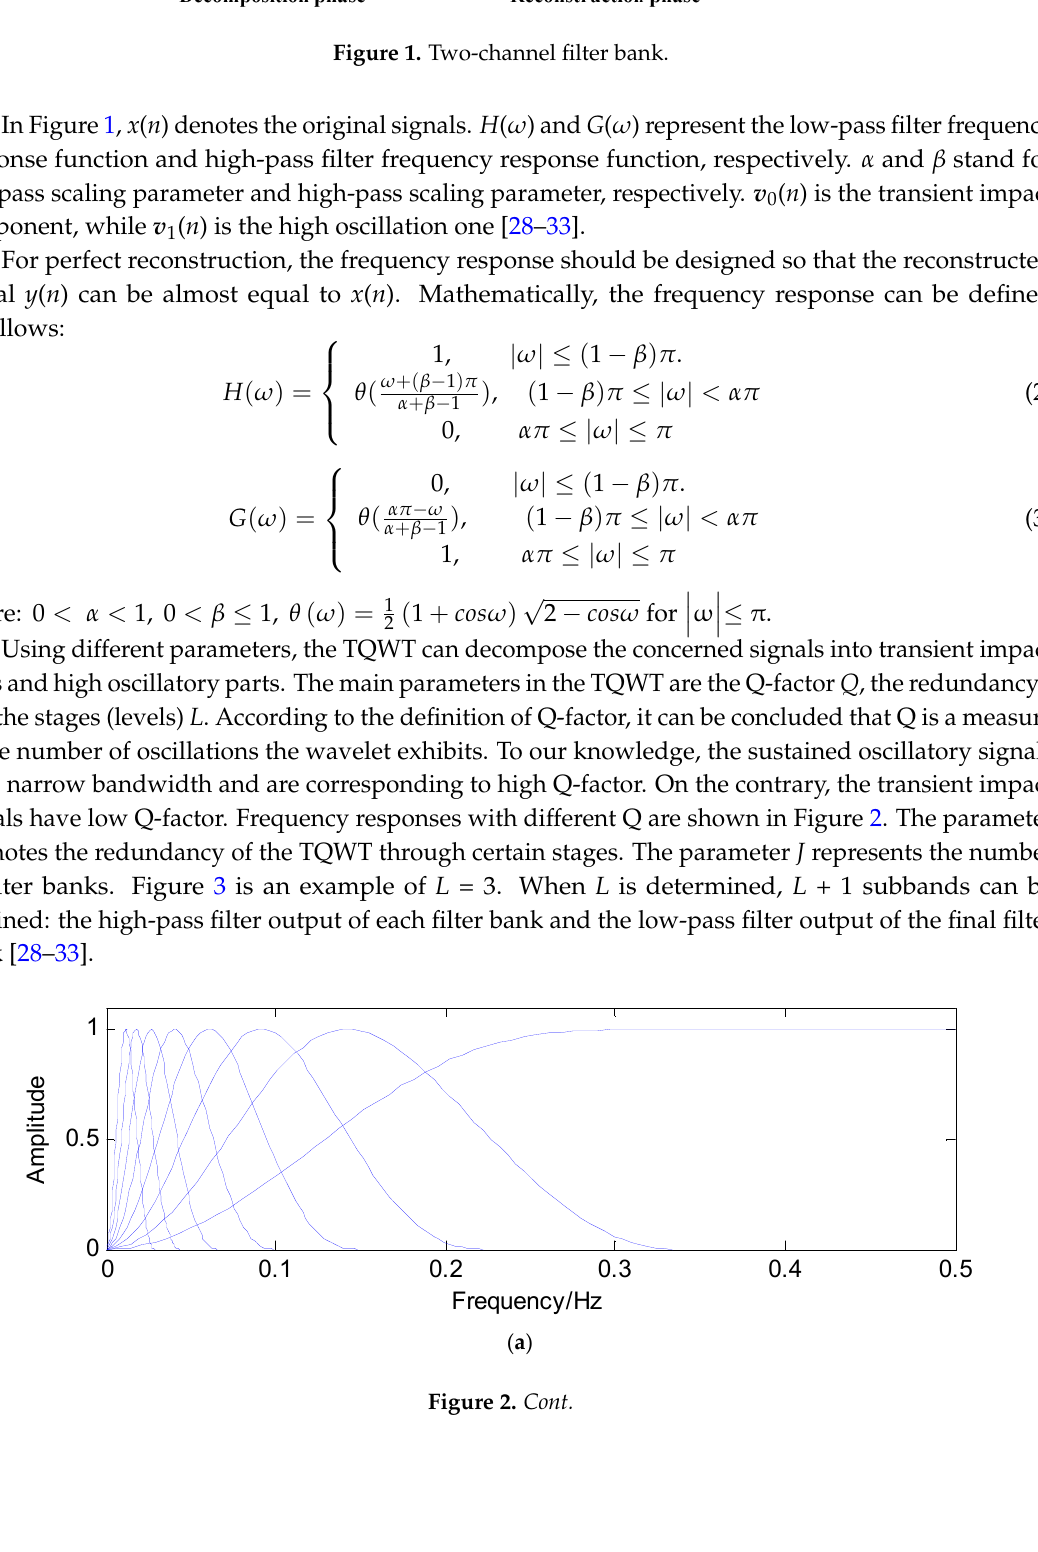
Figure 1. Two-channel filter